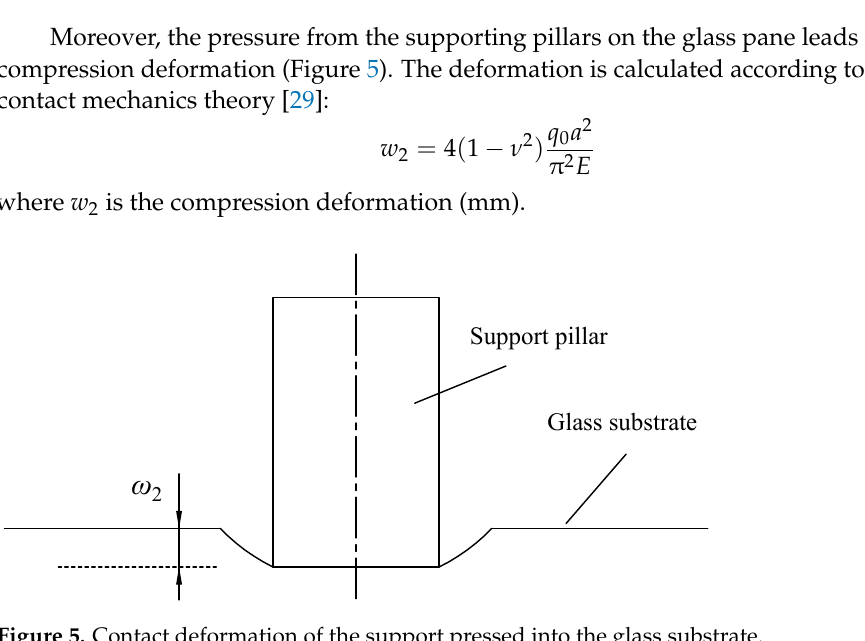
Figure 5. Contact deformation of the support pressed into the glass substrate.